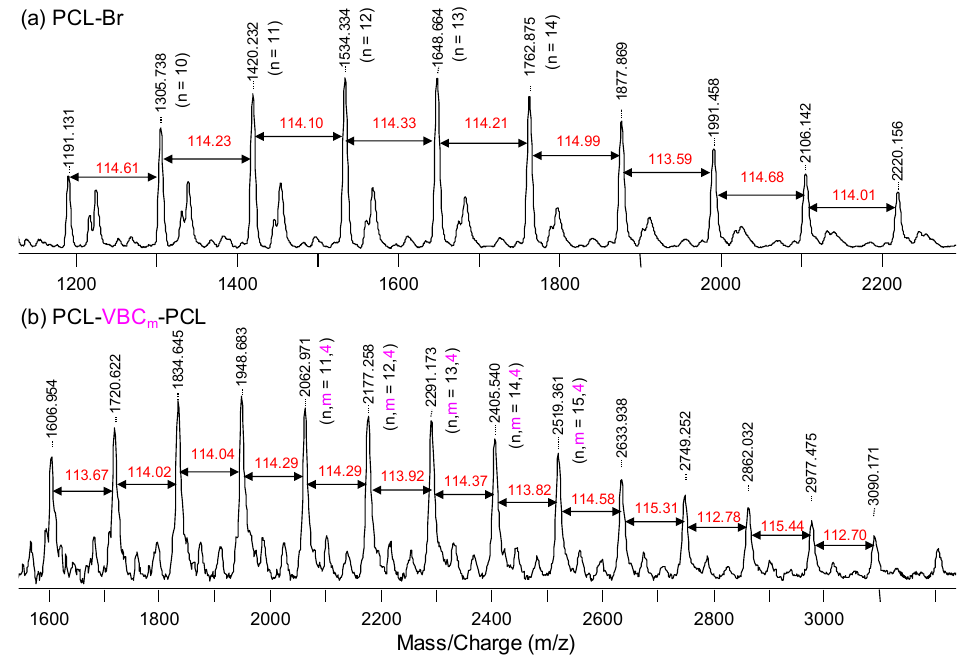
Figure 3. MALDI-TOF MS of ( a ) PCL–Br and ( b ) PCL-VBC m -PCL polymers (n: repeating units of CL). The obtained PCL-VBC 4 -PCL polymer was then used as a macroinitiator (MI) for chain extensions through ATRP from the mid-chain functional moiety of benzylic chlorides. Generally, a first order kinetic is examined to interpret the living polymerization fashion through a Ln vs. t plot (i.e., Ln(M 0 /M) = k app t where M 0 is the initial concentration of monomer, M is the concentration of monomer at time, and k app is the apparent reaction rate constant that is the multiplication of propagation rate constant and concentration of the propagating radical (i.e., k app = k p [M•]) [26]. Figure 4A demonstrates the kinetic plot of the chain extension with St monomer (St/PCL-VBC 4 - PCL/CuCl/PMDETA = 500/1/1/1 in anisole at 70 °C; [St] 0 = 4.3 M). A first-order kinetic plot showed a linear relationship with a k app value of approximately 4.67 × 10 –6 s − 1 . Figure 4B displays the GPC traces of the corresponding periods of reaction time. A gradual growth of MWs (values of M n increased from 5.8 k to 17 k g/mol) with monomodal traces and low PDIs (<1.4) were observed during the chain extension. The results indicated a typical controlled/living radical polymerization fashion and we successfully synthesized PCL 2 - μ -PSt 4 miktoarm star copolymers. Figure 5A displays the kinetic plot at 70 °C; [tBA] 0 = 3.4 M). A first-order kinetic plot showed a linear relationship with a k app value of approximately 5.72 × 10 –5 s − 1 that is approximately an order magnitude faster than that of the St case.